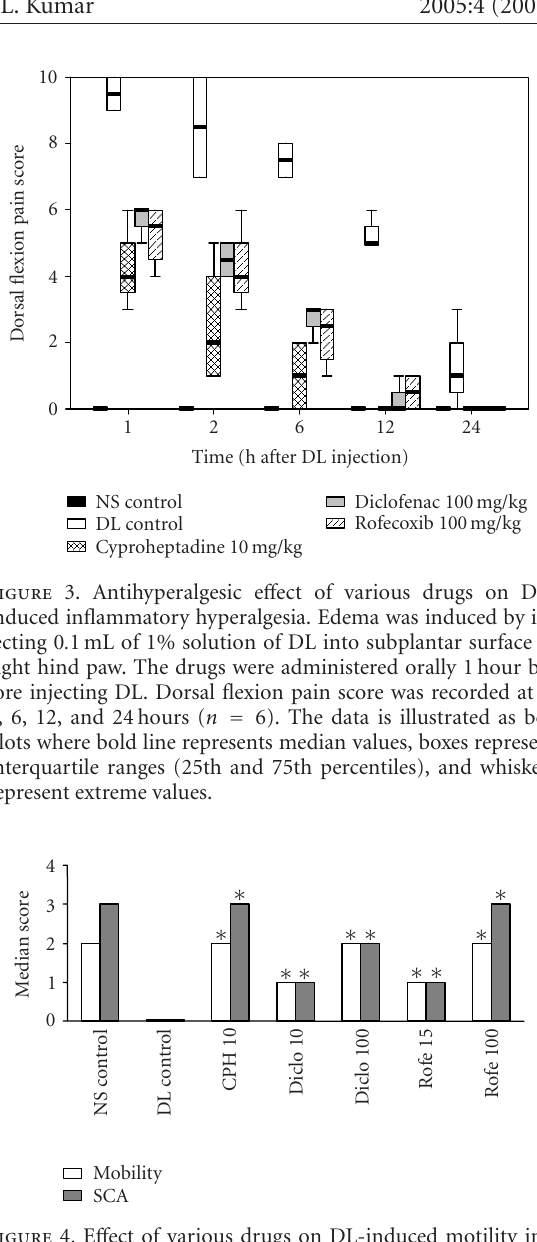
Figure 4. E ff ect of various drugs on DL-induced motility im- pairment and staircase climbing ability (SCA). Edema was in- duced by injecting 0 . 1mL of 1% solution of DL into subplantar surface of right hind paw. The drugs were administered orally 1hour before injecting DL. Motility and staircase climbing abil- ity were observed at 2hours ( n = 6). ∗ P < . 01 versus DL